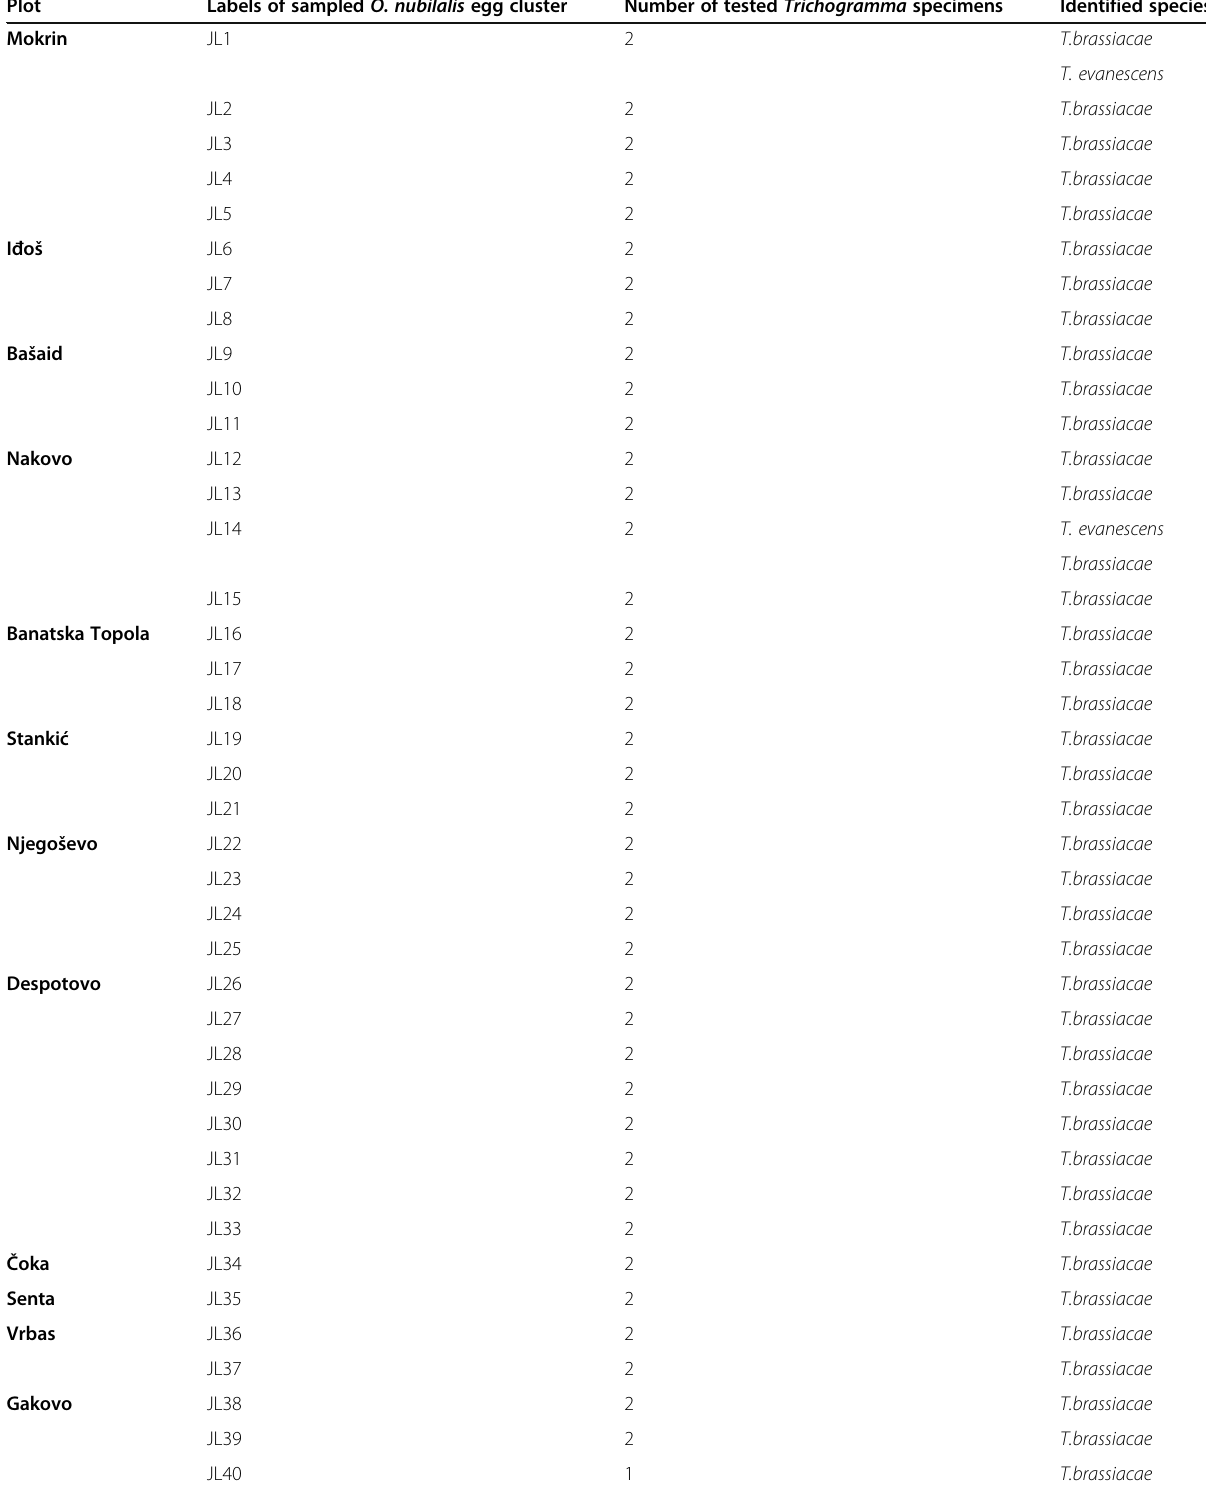
Table 3 Results of the molecular identification of sampled Trichogramma individuals on the territory of Vojvodina in 2017 Plot Labels of sampled O. nubilalis egg